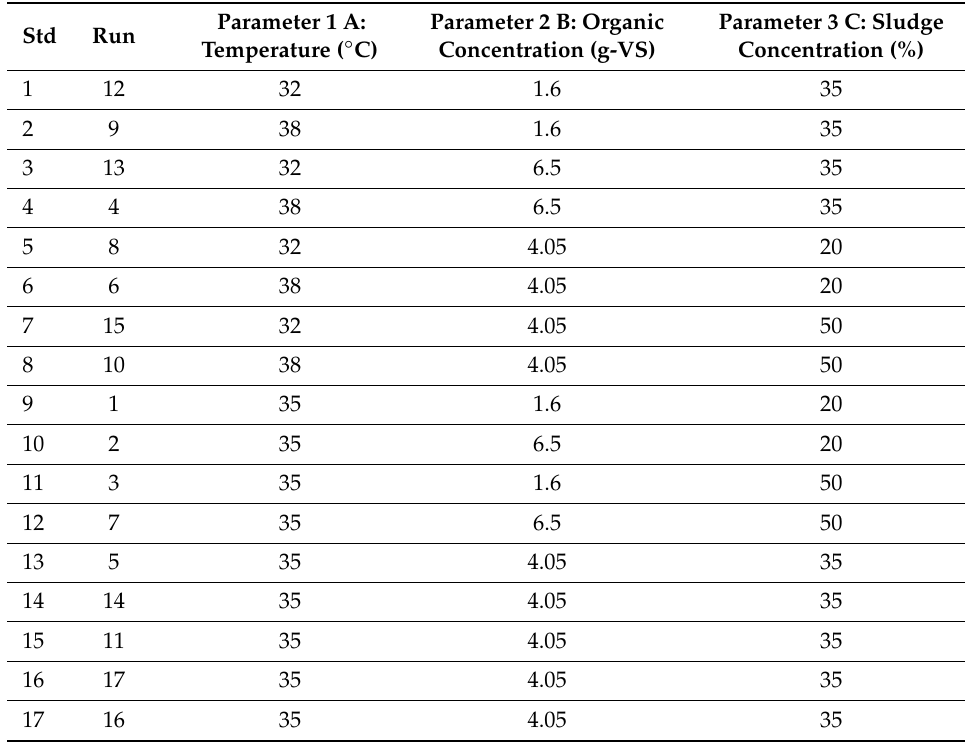
Table 2. The design matrix in actual